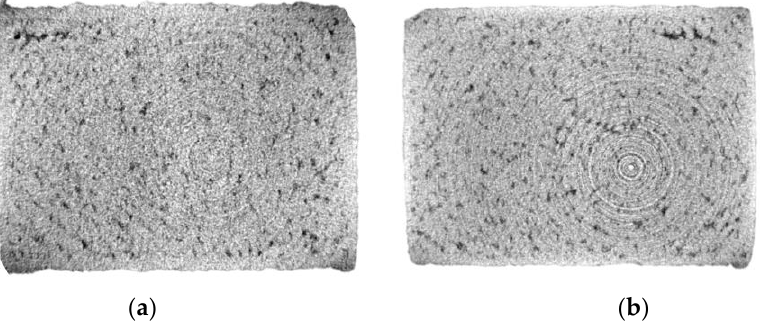
Figure 10. Computed Tomography data of high-purity copper, where ( a ) is Carpenter Additive Cu #2 (porosity 14.63%) and ( b ) is Carpenter Additive Cu #3 (porosity 11.85%).